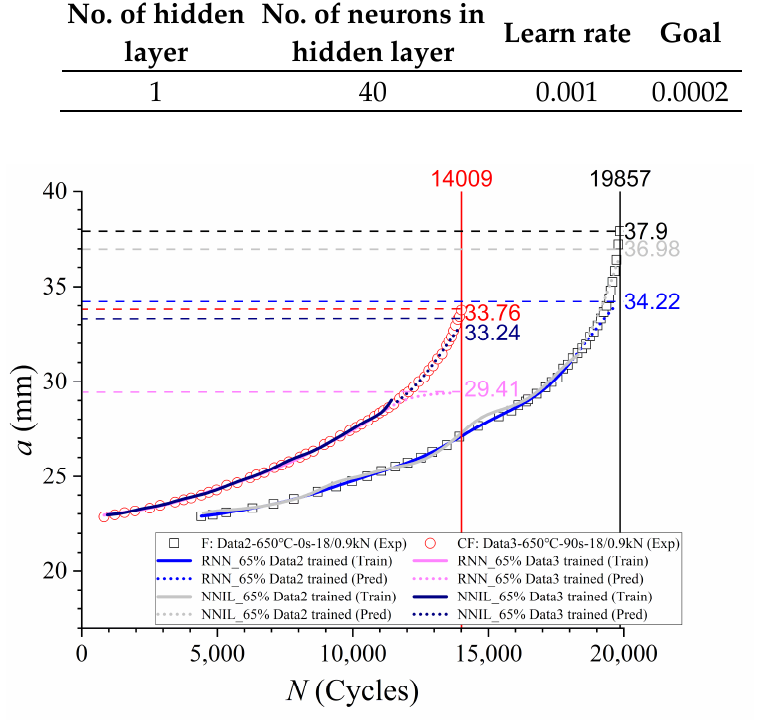
Figure 11. a - N curves prediction using RNN and NNIL scheme for Data2 and Data3, respectively.